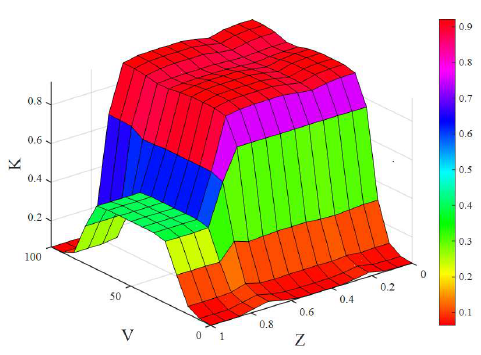
Figure 11. Relationship between K , Z, and V .